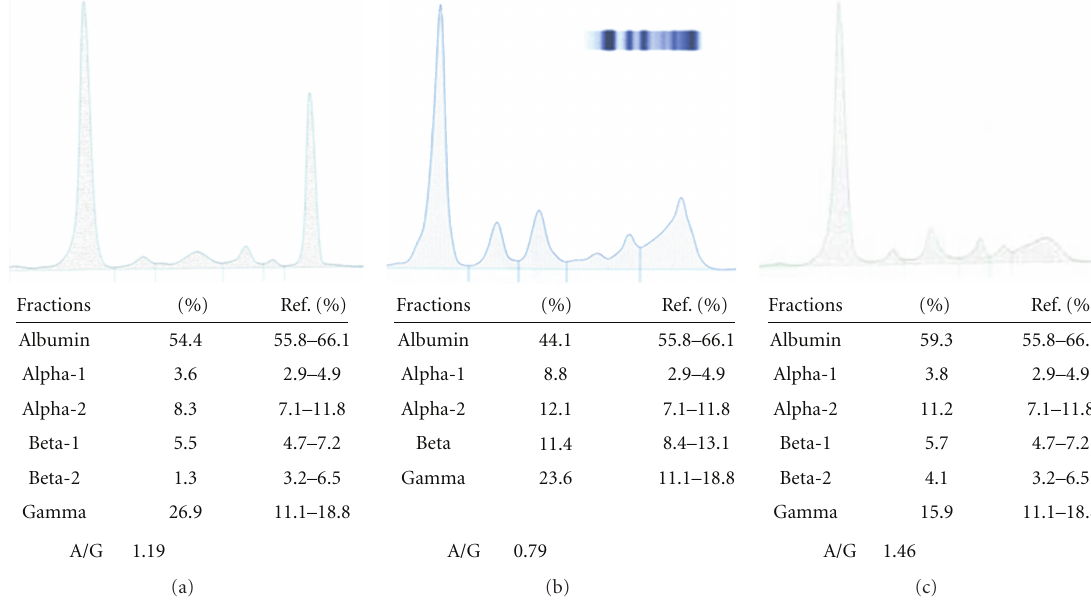
Figure 2: (a) Serum electrophoresis indicates a monoclonal component in the gamma region. (b) After two months a minor monoclonal component is detected. (c) Serum electrophoresis after three-month treatment shows normal albumin and globulin fractions.